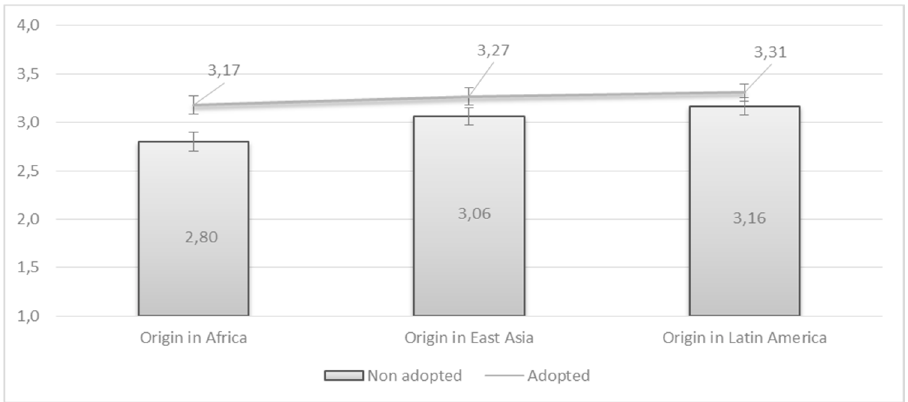
Figure 3. Is it accepted in Swedish society to intermarry? Respondents of white European background (N = 416, %).